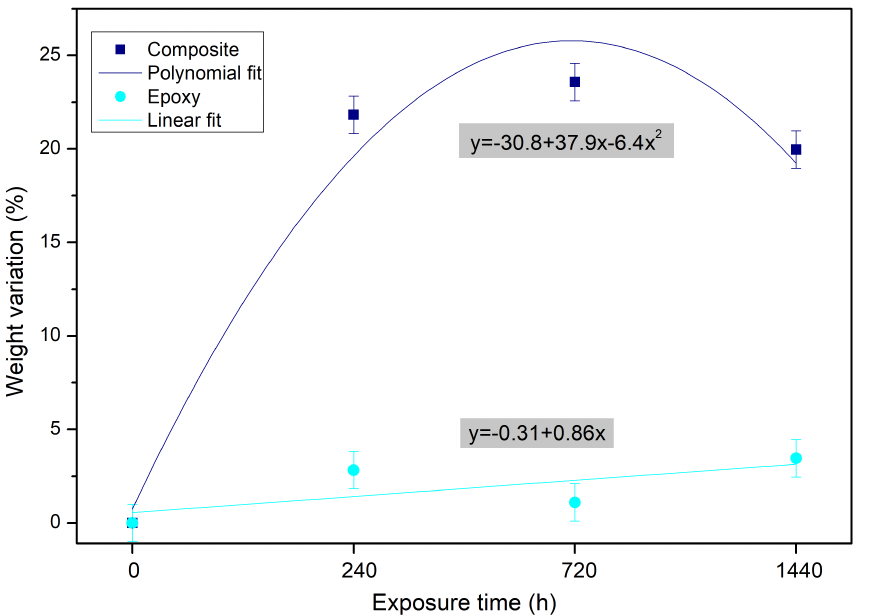
Figure 4. Weight variation of epoxy and fique fabric–reinforced epoxy matrix composite during water immersion